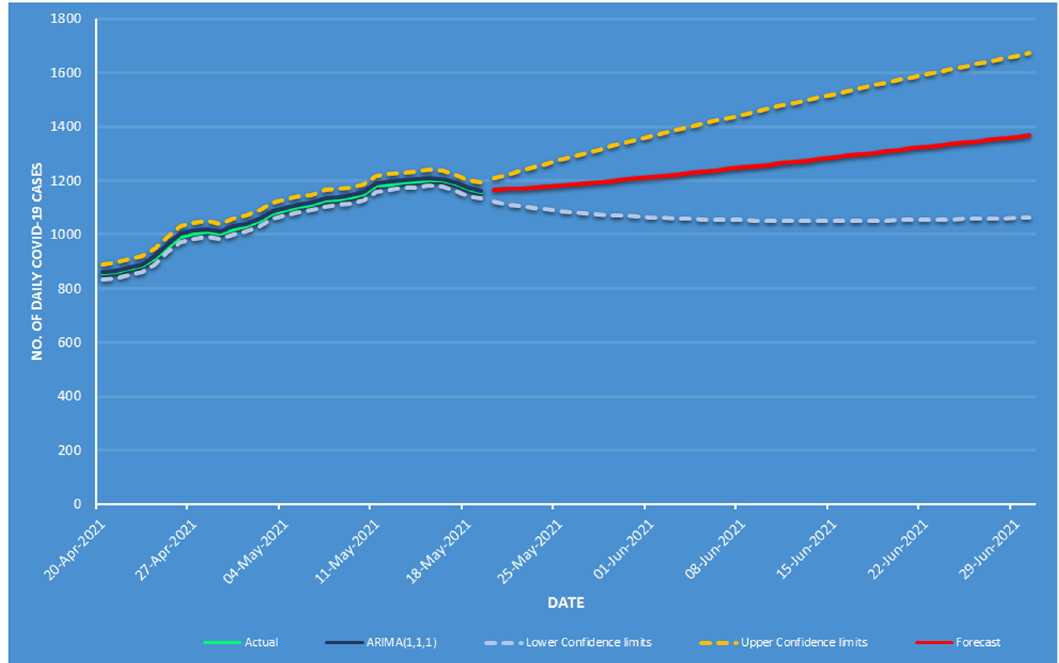
Figure 7: The actual and predicted number of Daily COVID - 19 cases in Egypt from April 20, 2021, to June 30,